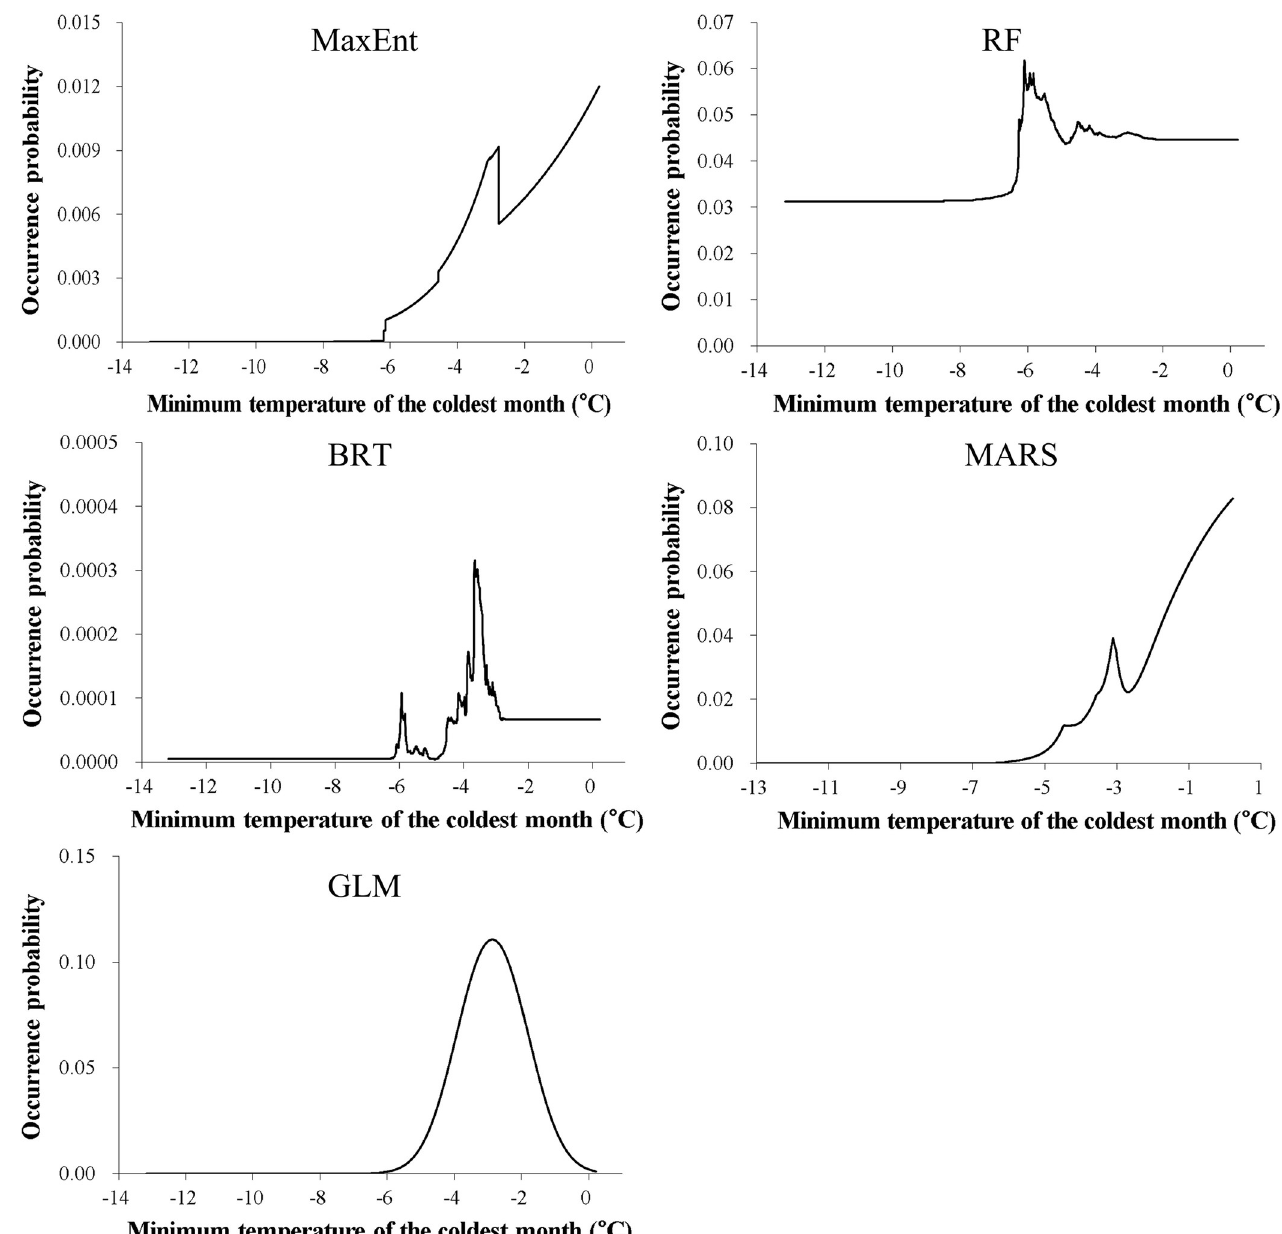
Fig 3. Response curves for the most important predictor, the minimum temperature of the coldest month for the five species distribution models for nutrias (producing Δ AUC values � 0. 05). MaxEnt = Maximum Entropy; RF = Random Forest; BRT = Boosted Regression Trees; MARS = Multivariate Adaptive Regression Spline; GLM = Generalized Linear